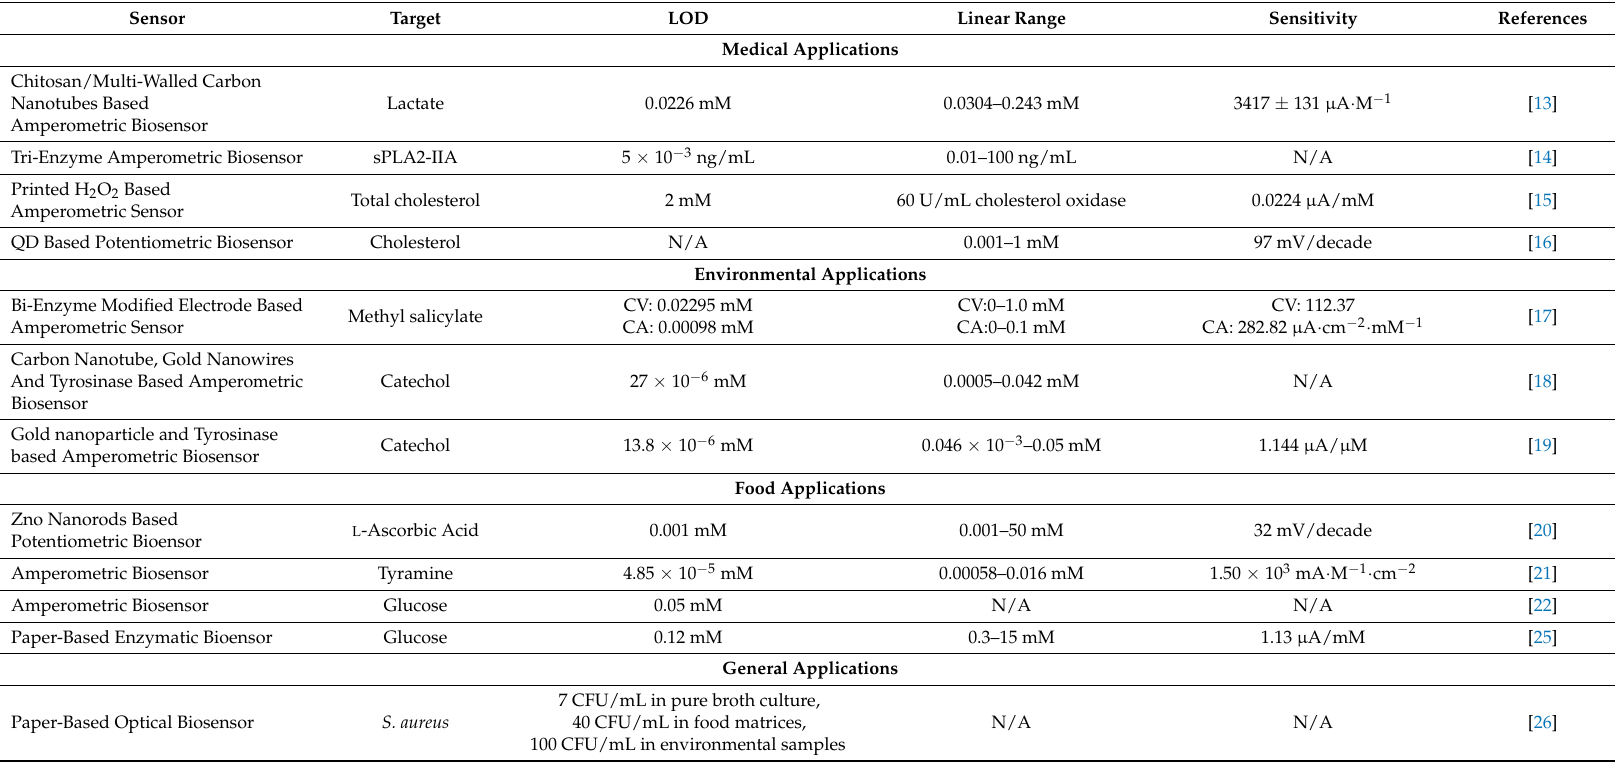
Table 1. Analytical performances of recent publications on enzymatic